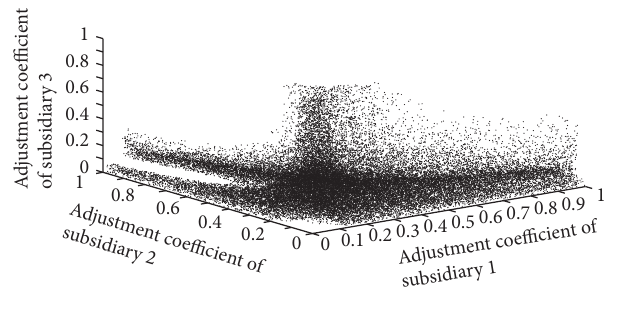
Figure 1: The stability region of the Nash equilibrium.